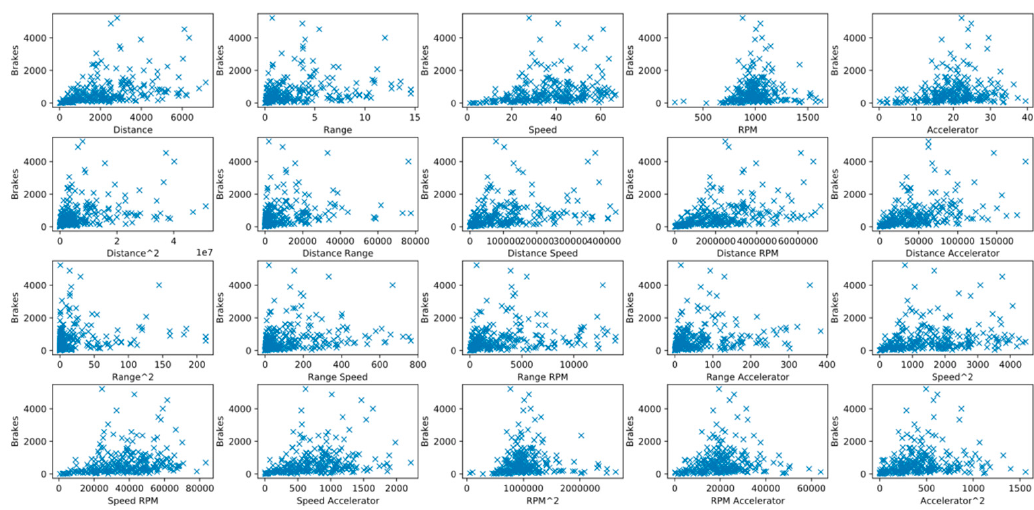
Figure 5. Relationship between “Brakes” and its independent variables.